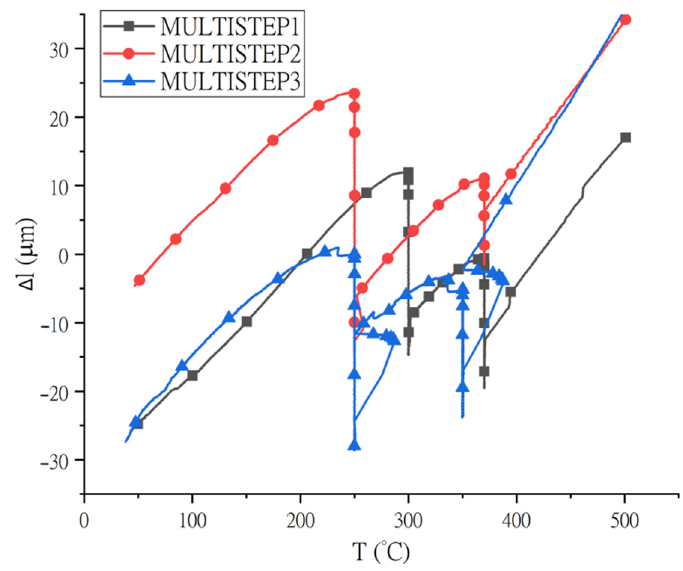
Figure 4. Cooling branch of the dilatometric curve showing the change in length ( ∆ l) against temperature for the multi-step austempering treatments indicating the bainitic transformation during all the austempering steps.